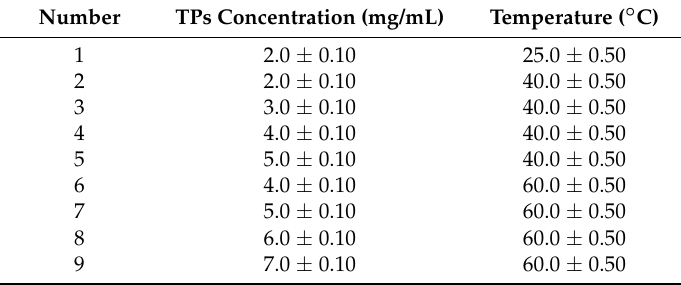
Table 4. The preparative parameters of TP 5